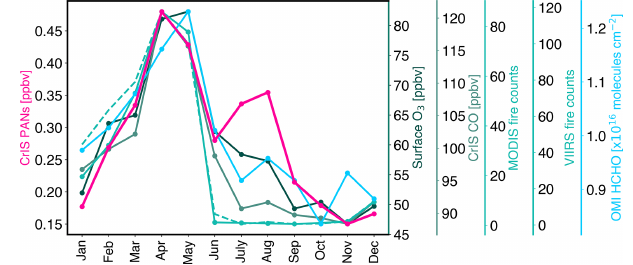
Figure 6. Seasonal cycle of CrIS free-tropospheric PANs, RAMA surface O 3 , CrIS free-tropospheric CO, MODIS fire counts (solid: 2016–2020), VIIRS fire counts (dashed), and OMI HCHO columns for urban Mexico City from 2016 to 2021. MODIS and VIIRS fire counts are constrained by (20.12 ◦ N, 100.40 ◦ W, 18.36 ◦ N, 98.44 ◦ W). All other species are constrained by the urban Mexico City box defined in Fig.